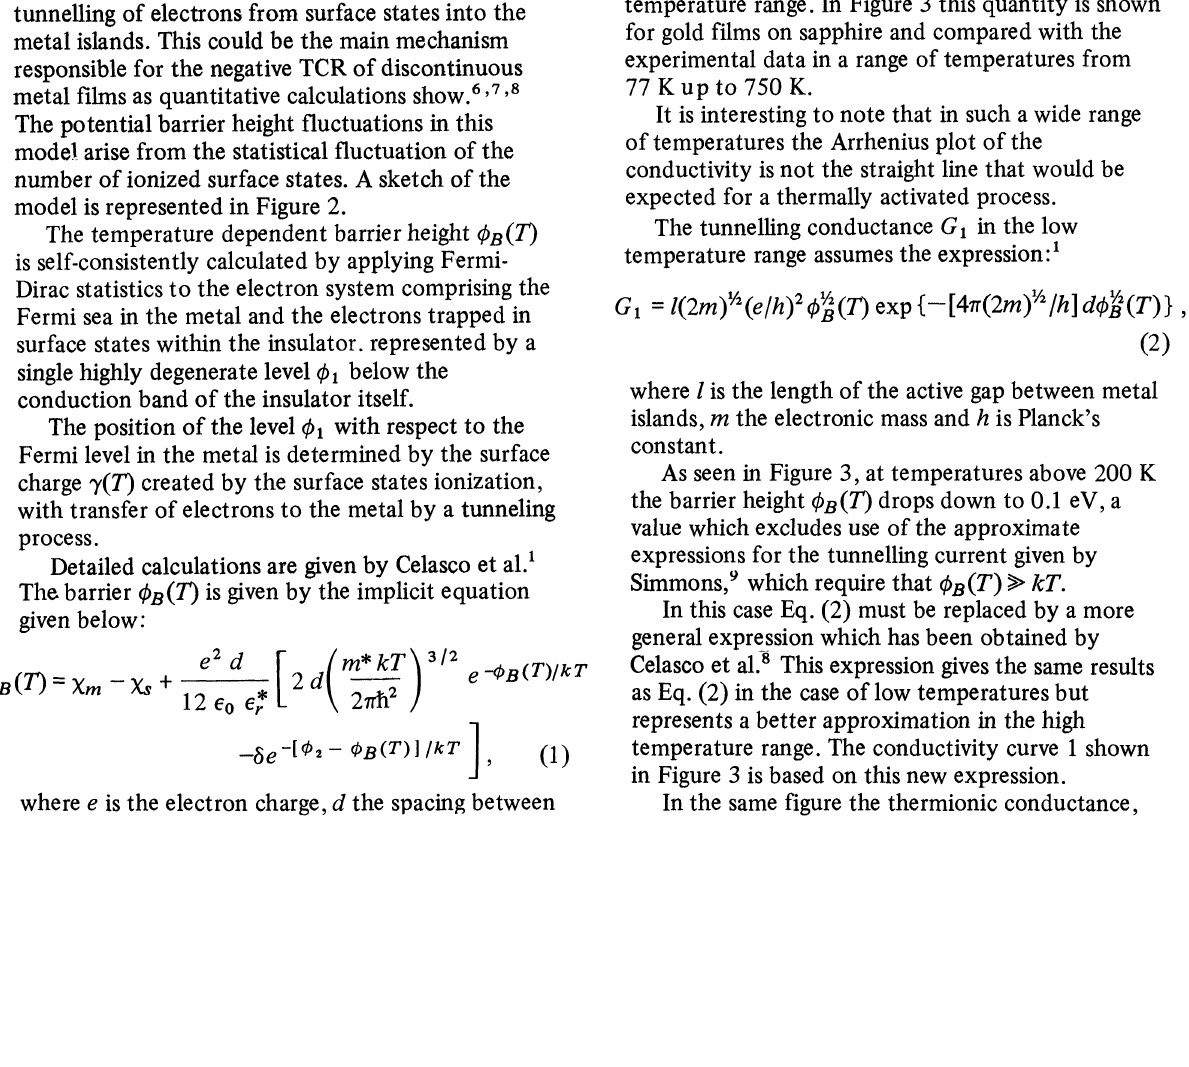
Energy diagram for the metal-island to substrate contact. m and s are the electron work functions for the metal and the insulator respectively, 1 is the energy of the surface state level with respect to the conduction band of the insulator, and B the potential barrier